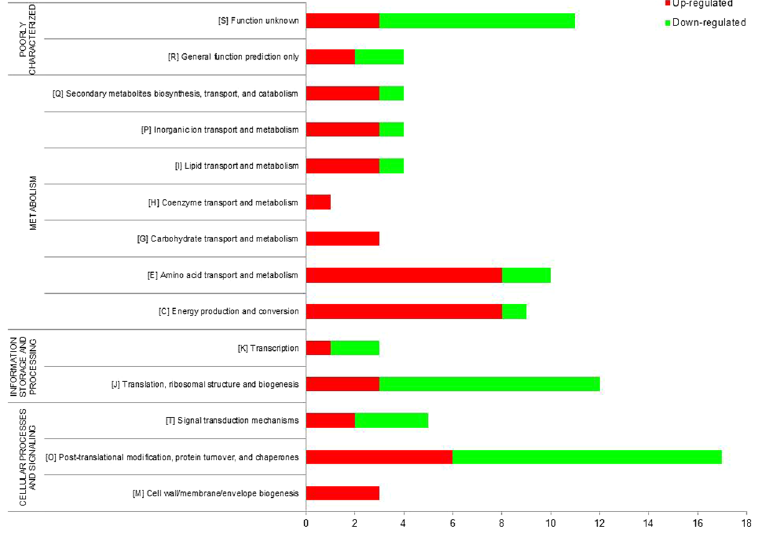
Figure 4. Prediction of the functional protein categories of differently expressed Bp MARAN and Bp mouse-adapted proteins. The identified proteins were assigned into functional classes of based on Cluster of Orthologous Groups (COG) and Gene Ontology (GO) for the proteins functional categories (metabolism, cellular processing and signal, information storage and processing and poorly characterised proteins). (red: up-regulated; green: down-regulated).